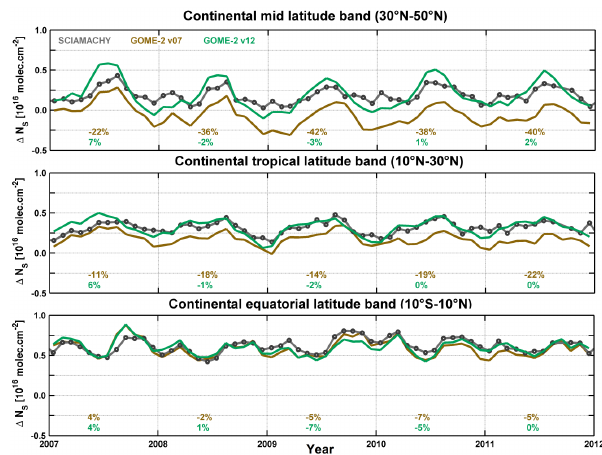
Figure 2: Monthly H 2 CO differential slant columns averaged in 3 latitude bands over continents, as Fig. 2. Monthly H 2 CO differential slant columns averaged in 3 lat- retrieved from SCIAMACHY and GOME-2 measurements. The maroon line shows the GOME-2 itude bands over continents, as retrieved from SCIAMACHY and results obtained with the initial retrieval settings (v07), while the green line shows the results GOME-2 measurements. The maroon line shows the GOME-2 re- obtained with the improved settings (v12, see text for details). Averaged relative differences sults obtained with the initial retrieval settings (v07), while the between GOME-2 and SCIAMACHY observations are given at the bottom of each subplot, for green line shows the results obtained with the improved settings each year and for the two versions of the GOME-2 results. (v12, see text for details). Averaged relative differences between GOME-2 and SCIAMACHY observations are given at the bot- tom of each subplot, for each year and for the two versions of the GOME-2